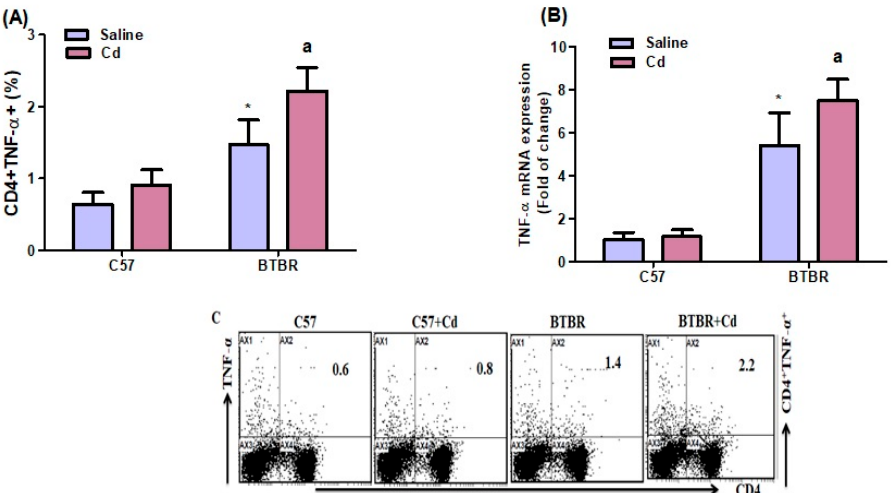
Figure 4. Effects of oral Cd exposure on TNF- α . ( A ) TNF- α -expressing CD4 + T cells from the spleen. ( B ) TNF- α mRNA expression in brain tissue. ( C ) Representative FSC-SSC dot plots of CD4 + TNF- α + cells taken from each mouse spleen. BTBR and C57 mice were orally administered Cd (5 mg/kg/day) or saline (control) daily for six weeks. All data are shown as mean ± SD ( n = 6/group). Different letter indicate significant difference. * p < 0.05 vs. saline-treated C57 mice, ap < 0.05 vs. saline-treated BTBR mice; two-way ANOVA with Tukey’s